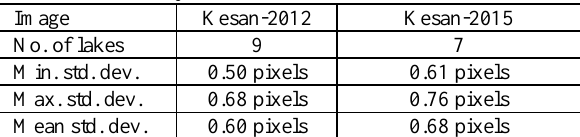
Table 4. Noise analysis results.